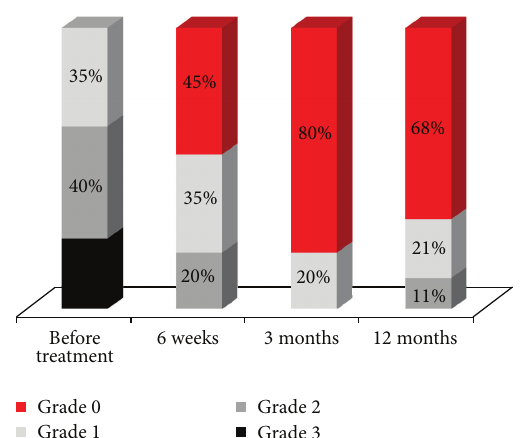
‡ 𝑃 < 0.001 for all visits versus baseline. $ 𝑃 < 0.01 for visit II versus baseline. Values presented in mean (SD).